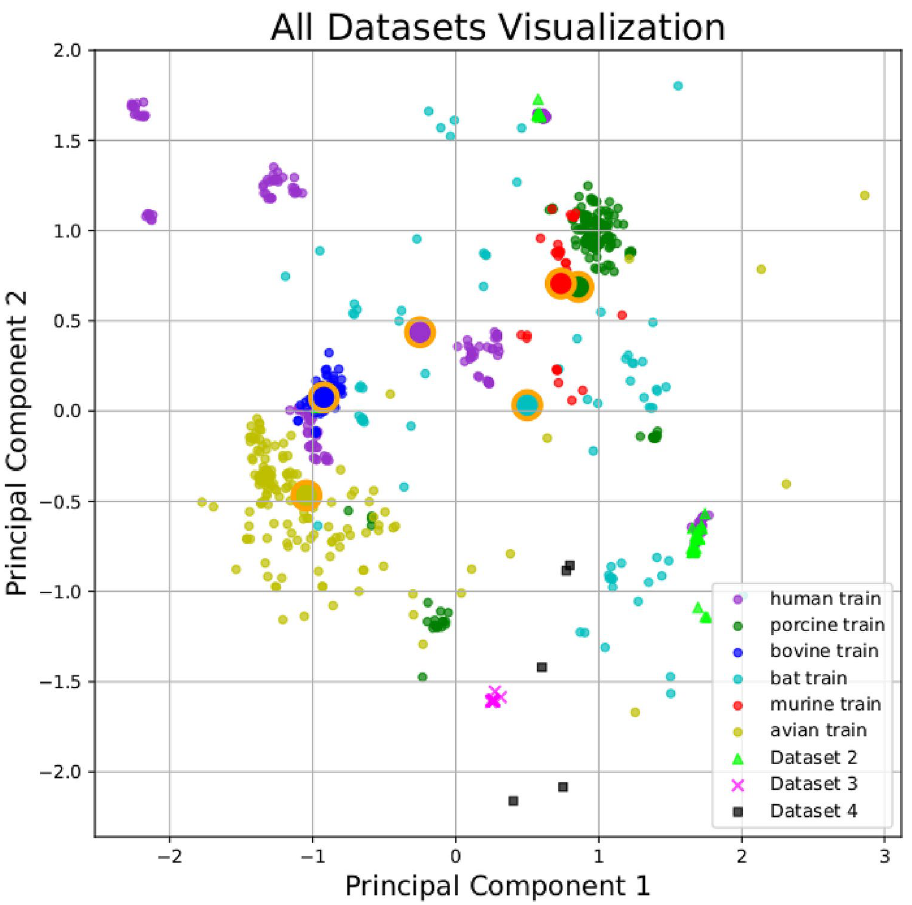
Figure 3. PCA reduction, all datasets. Dataset-1, training dataset; Dataset-2, testing; Dataset-3, SARS- CoV-2; Dataset-4, Bat Coronavirus, HCoV and Pangolin Coronavirus. Despite the Dataset-4 sequences being phylogenetically close to the Dataset-3 SARS-CoV-2 sequences 15 , we can notice that all of them do not cluster together when using RSCU as feature. Both Dataset-3 and 4 sequences were classified by our model as closer to bat coronaviruses than human